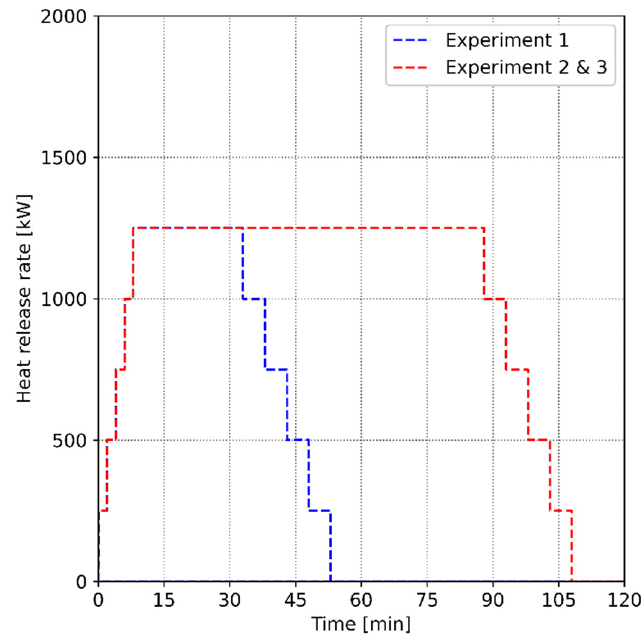
Figure 4. Time vs. burner HRR for all experiments.